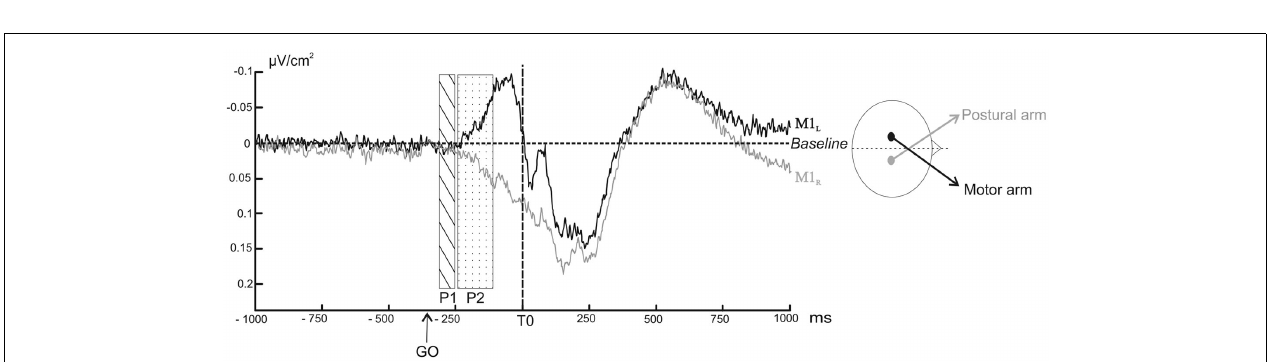
FIGURE 5 | Grand averages of surface Laplacians as a function of time over M1L (black line) and M1R (grey line) averaged across subjects. Negativity is up.The rectangular areas indicate the two time windows chosen